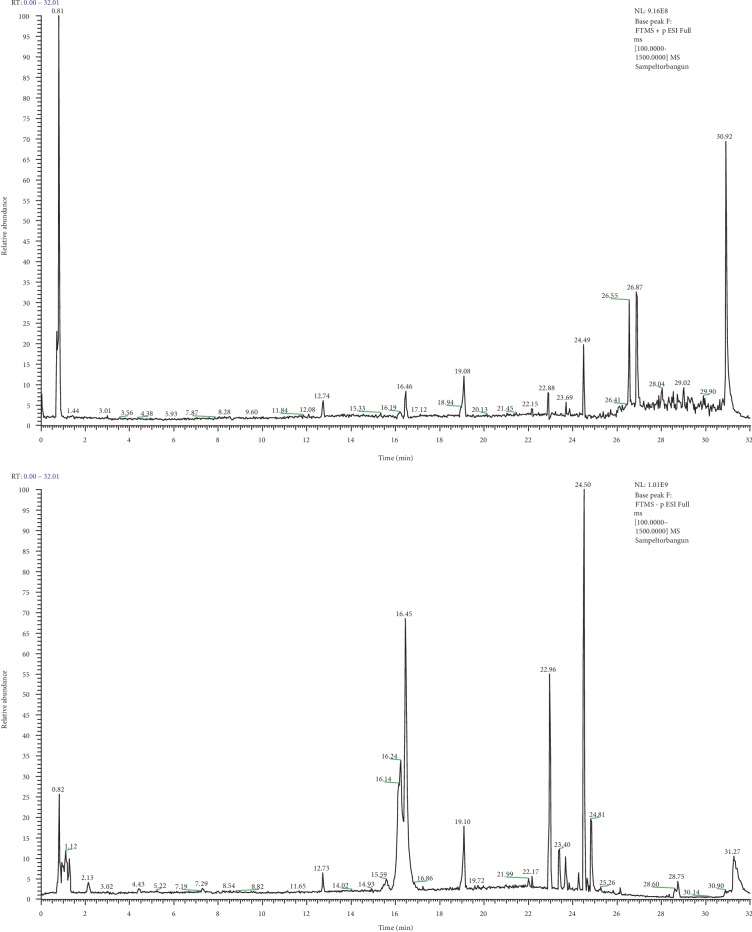
The Chromatogram of methanol extract of CA using Liquid Chromatography–Mass Spectrometry.